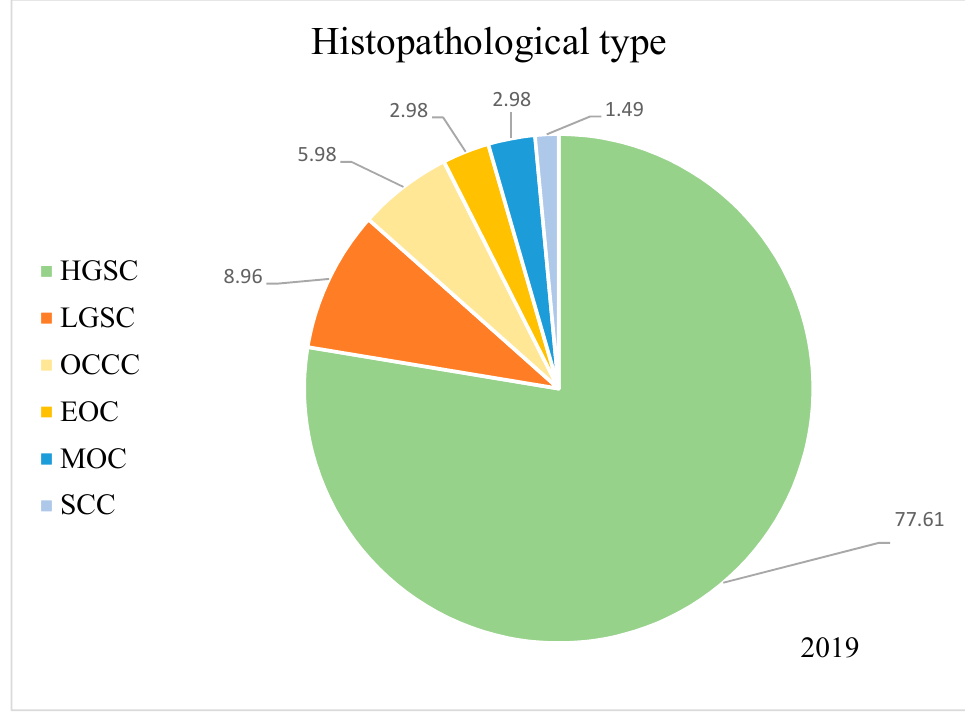
Figure 2. Histopathological types of OC in patients admitted in the year 2019. HGSC—high-grade serous carcinoma; LGSC—low-grade serous carcinoma; OCCC—ovarian clear-cell carcinoma; EOC—endometrioid ovarian cancer; MOC—mucinous ovarian cancer; SCC—squamous cell carcinoma.